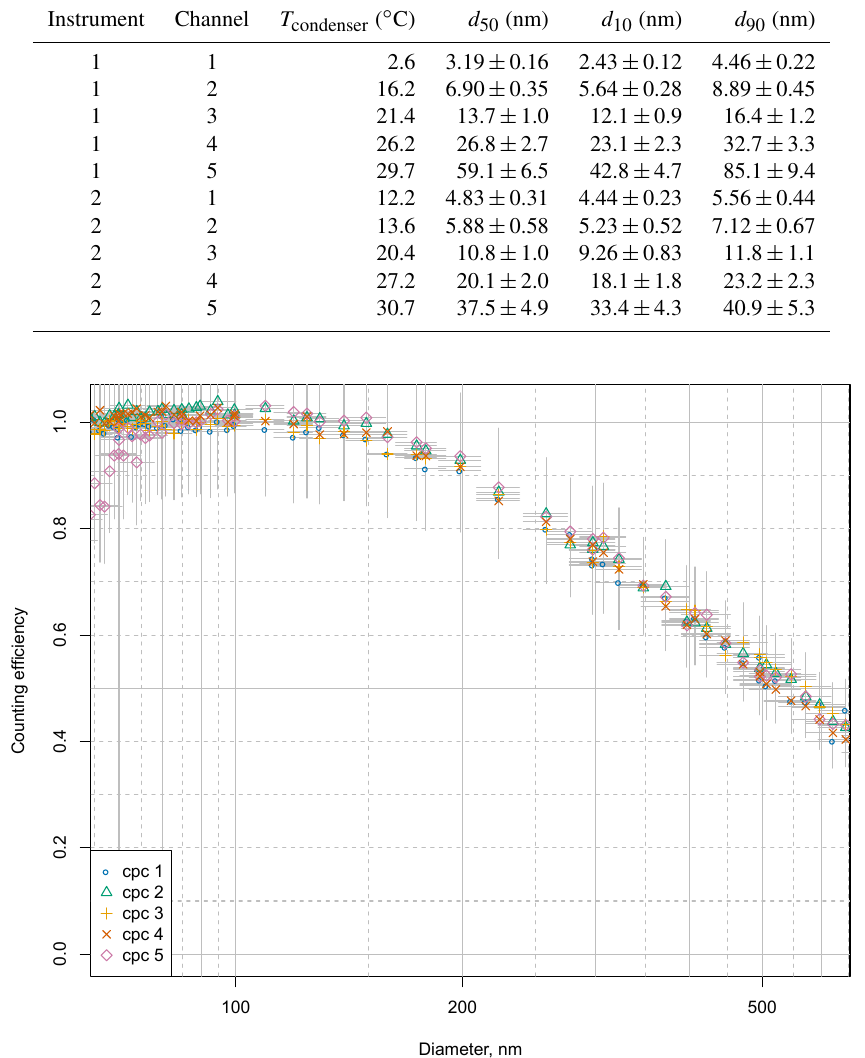
Table 1. Condenser temperatures, 50% cut-off diameters ( d 50 ), as well as 50, 10, and 90% counting efficiencies from the limonene ozonol- ysis calibration of the NMASS for a saturator temperature of 39.0 ± 0.1 ◦ C.